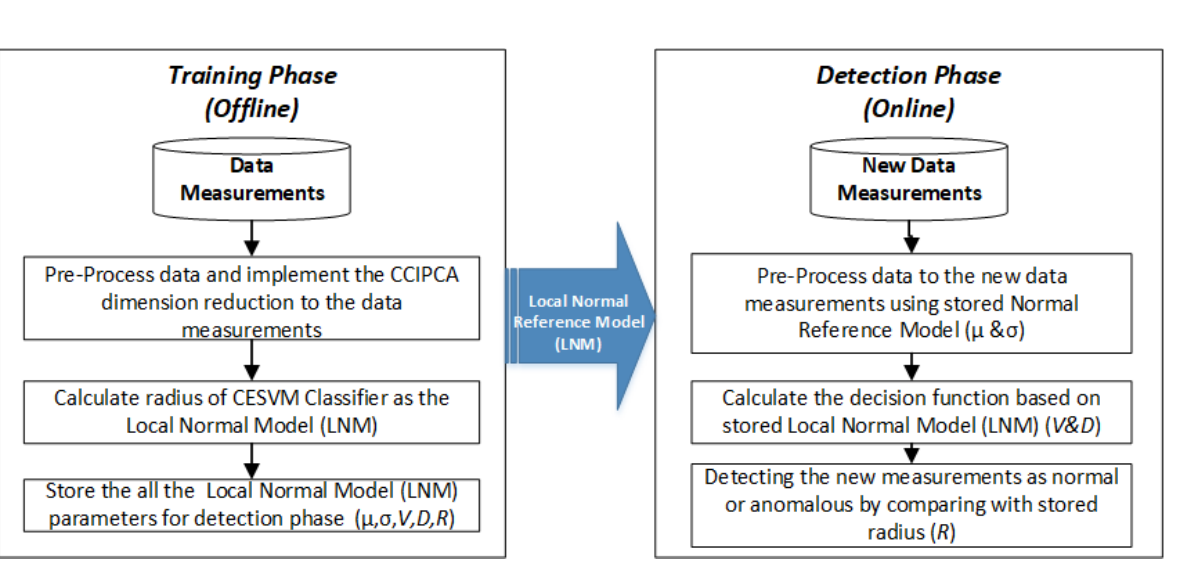
Figure 2. The training and detection phase of the proposed CESVM-DR anomaly detection scheme.